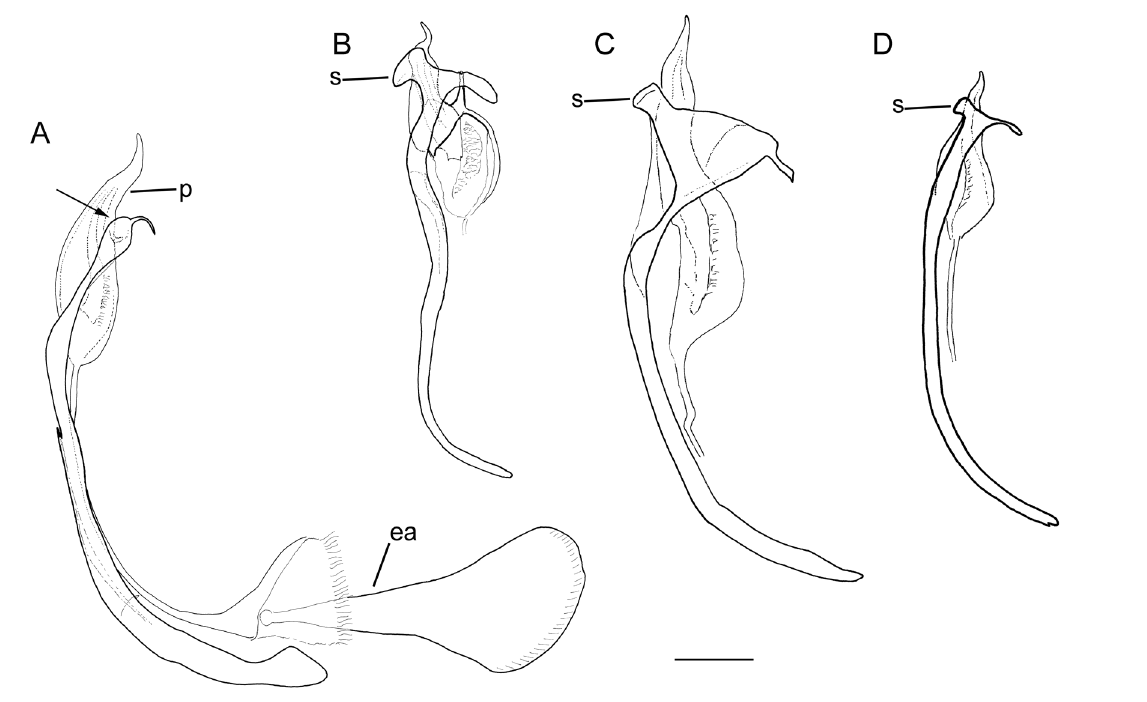
Fig. 3. Male genitalia, aedeagus, lateral view. A . Merodon aureus (Fabricius, 1805) (FSUNS; FSUNS ID 09662) the place of absence of lateral sclerite of the aedeagus marked with arrow. B . M.